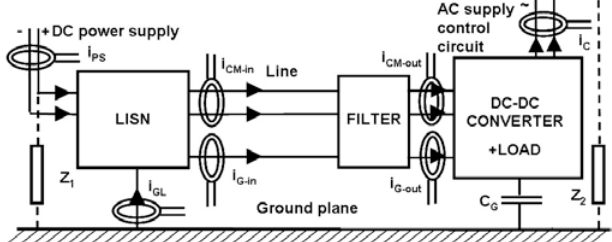
Figure 22: Setup CM current measurements with EMI filter.